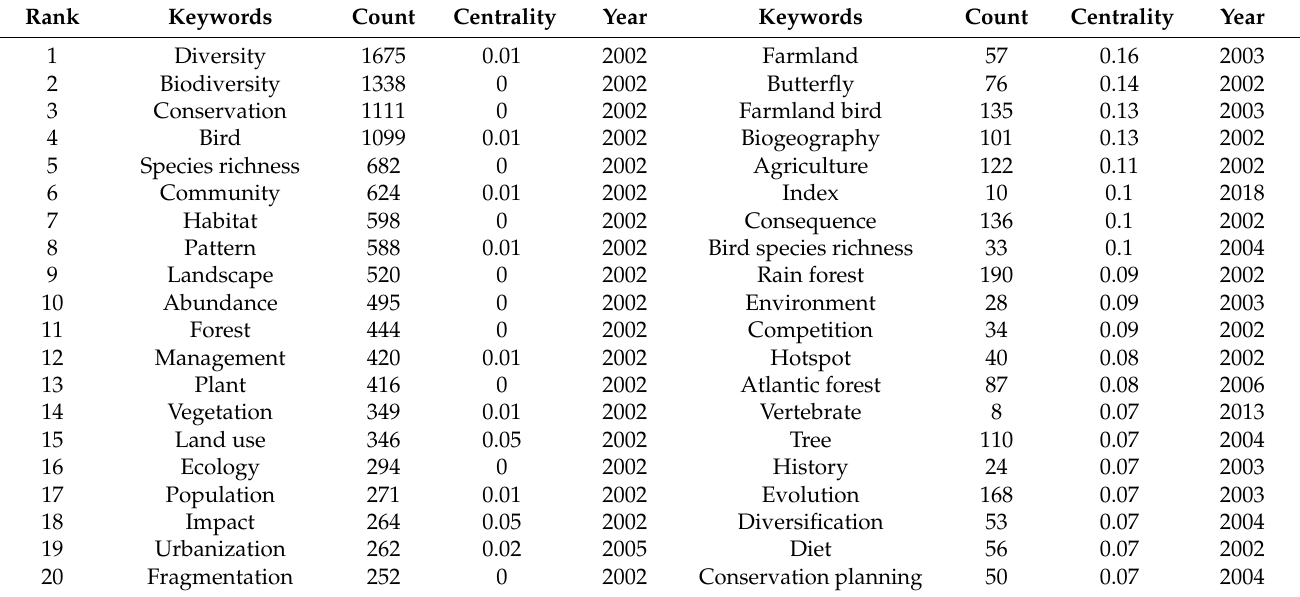
Table 4. The 20 keywords with the highest total number and concentration of research papers published in the